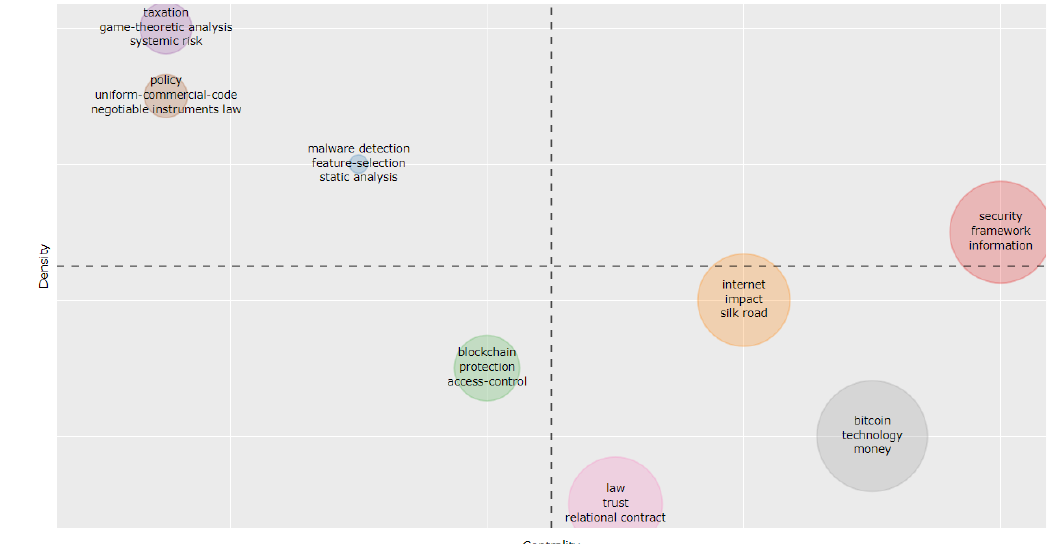
Figure 5. Strategic Diagram. TM Parameters: Field (Keyword Plus), Number of words (50–100), Min Cluster Frequency (1–5), Number of Labels (for each cluster 1–3), Label Size (0–0.2).